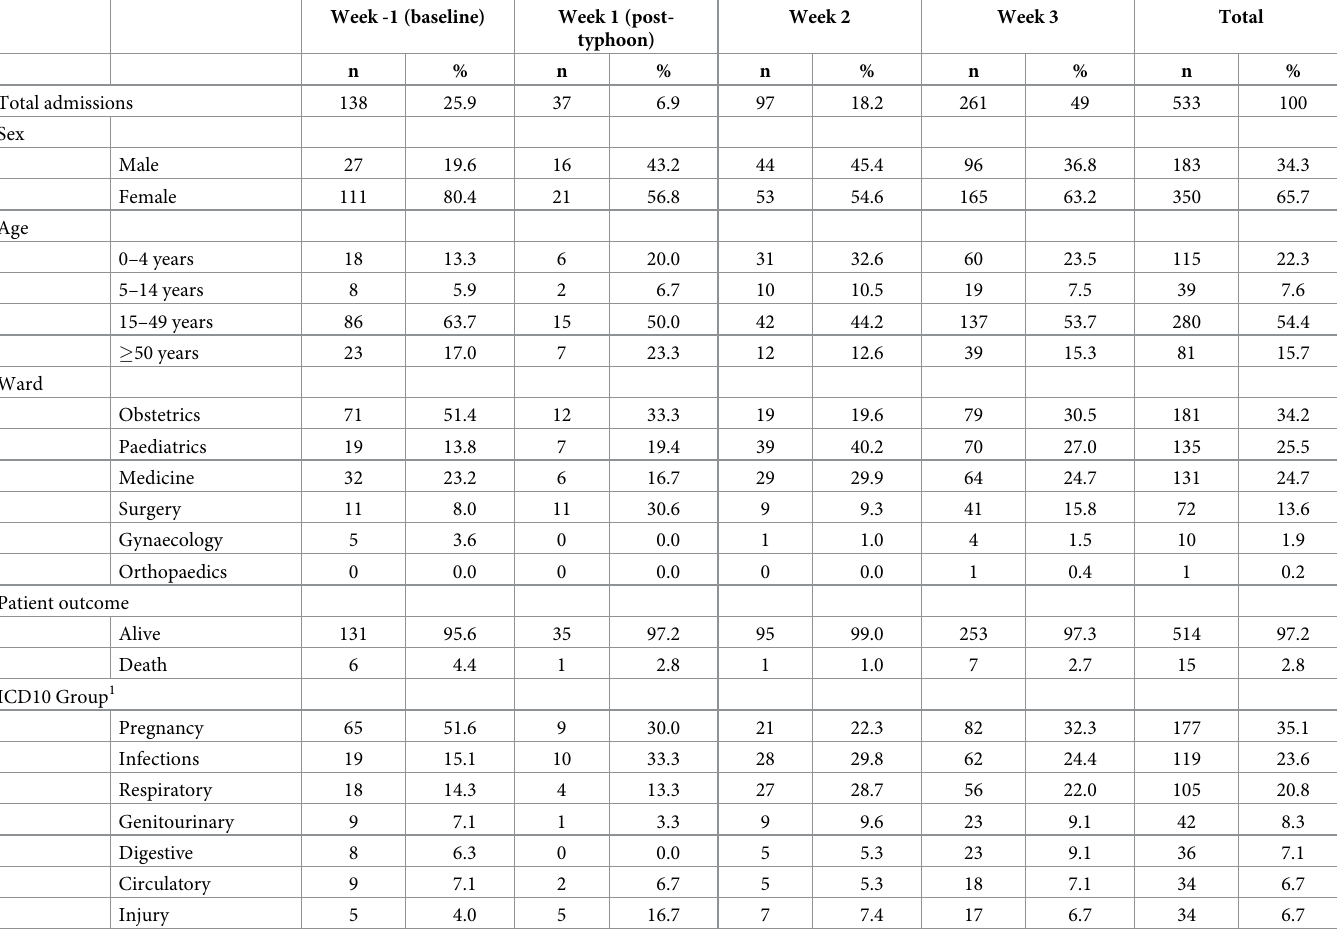
Table 2. Weekly admissions in Ormoc District Hospital in terms of sex, age, ward, patient outcome at discharge and diagnosis, one week before and three weeks after Typhoon